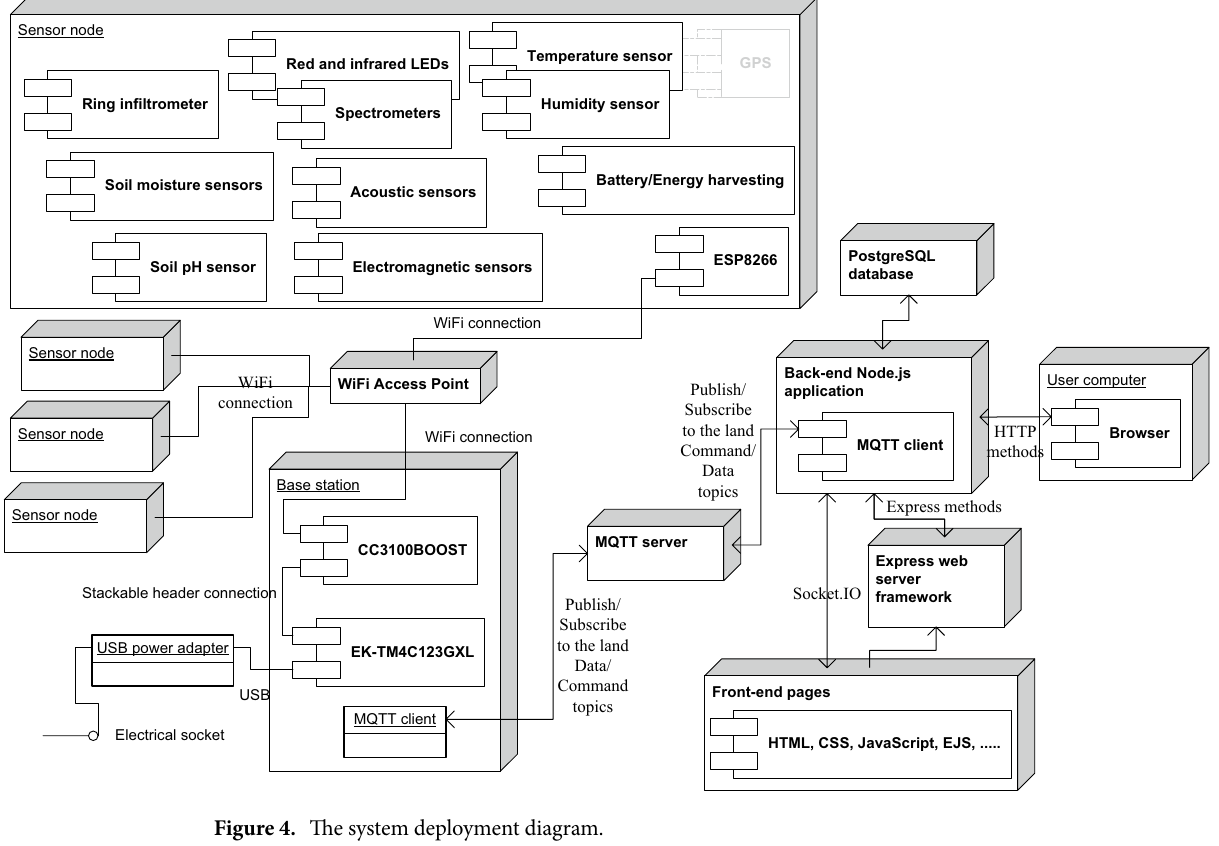
Figure 4. The system deployment